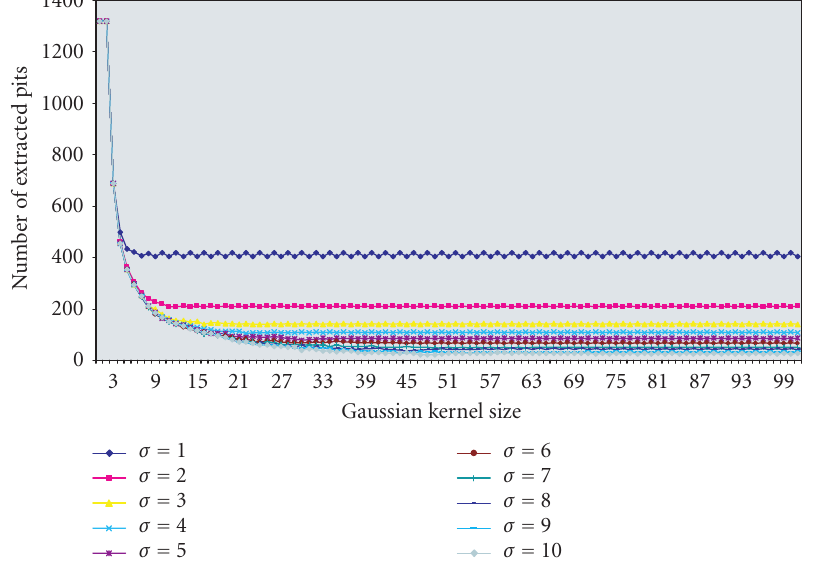
Figure 4.2. The e ff ect of Gaussian blurring on the extraction of pits from the DEM of Great